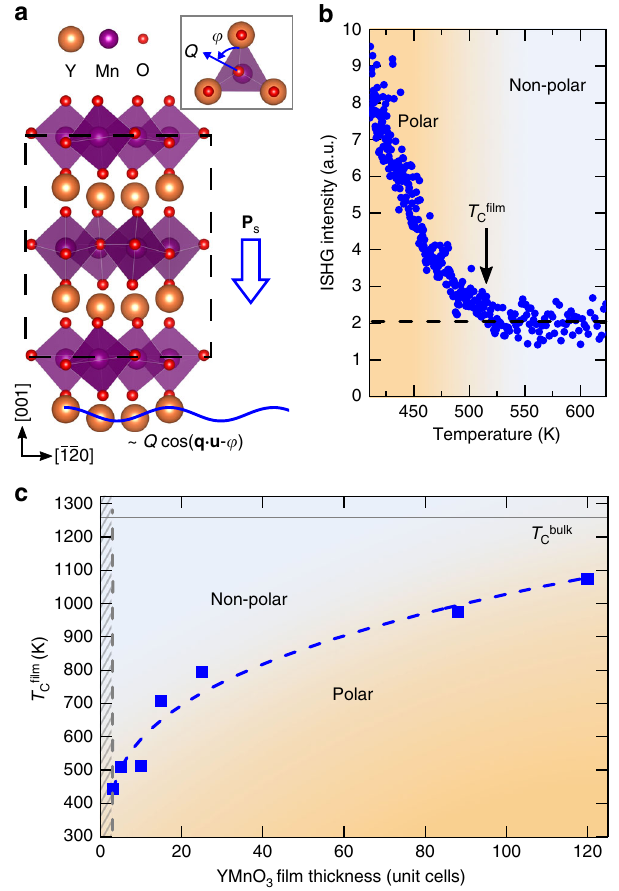
Fig. 1 Evolution of improper polarization in YMnO 3 thin fi lms. a Schematic of the ferroelectric P 6 3 cm YMnO 3 crystal structure. The lattice trimerization Q is given by the tilt amplitude Q and azimuthal tilt angle φ of the MnO 5 bipyramid (as de fi ned in the inset viewed along [001]), and equivalently by the sinusoidal corrugation pattern of Y atoms. The dashed line outlines the YMnO 3 unit cell. b Temperature dependence of the ISHG intensity from a 10-unit-cell YMnO 3 fi lm grown on YSZ upon cooling in the thin- fi lm growth environment. The dashed line indicates the background level caused by surface contributions. The onset of P s at the ferroelectric critical temperature fi lm (indicated by the arrow) breaks inversion symmetry, giving rise to an T C ISHG wave with an amplitude proportional to P s . c Ferroelectric transition temperatures for different YMnO 3 fi lm thicknesses. T C fi lm is extracted from ISHG measurements as in a . Films below three unit cells show no spontaneous polarization down to room temperature, indicated by the hatched gray area. Note that the thin- fi lm crystalline quality could be maintained up to a thickness of 120 unit cells (<140 nm). Within this investigated range, T C bulk = 1259K (gray horizontal line) has not yet been reached. The dashed line, serving as a guide to the eye, highlights the thickness